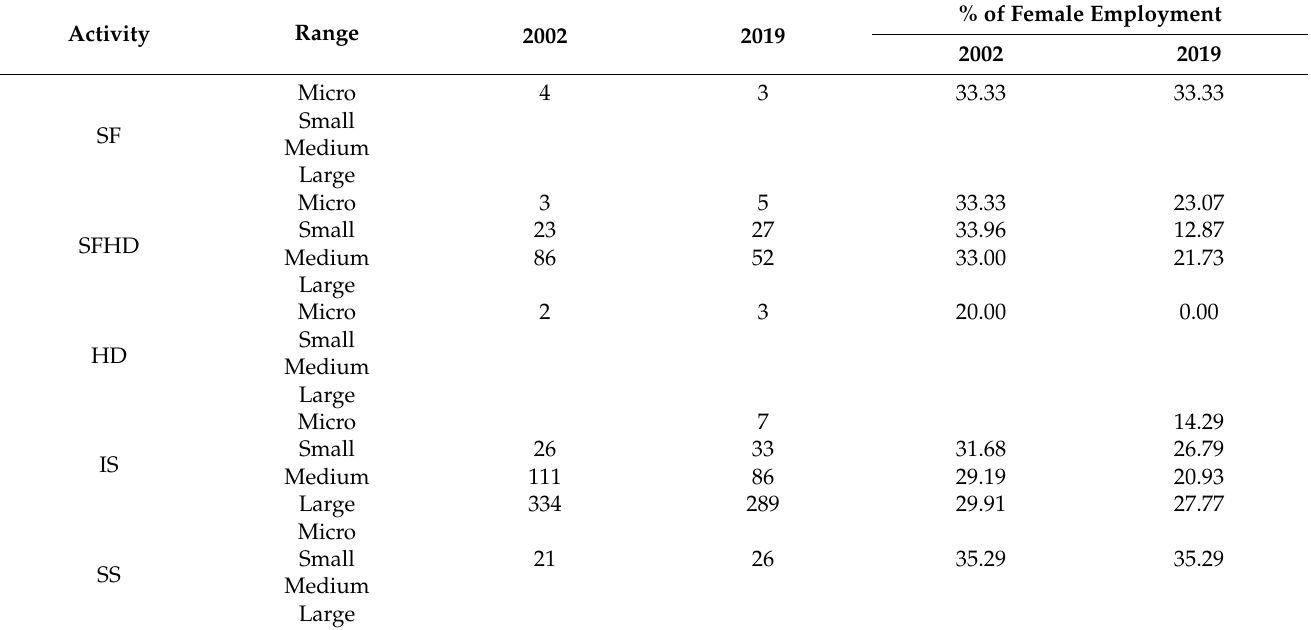
Table 8. Average employment by size and type of activity and % of female employment (2002 and 2019).